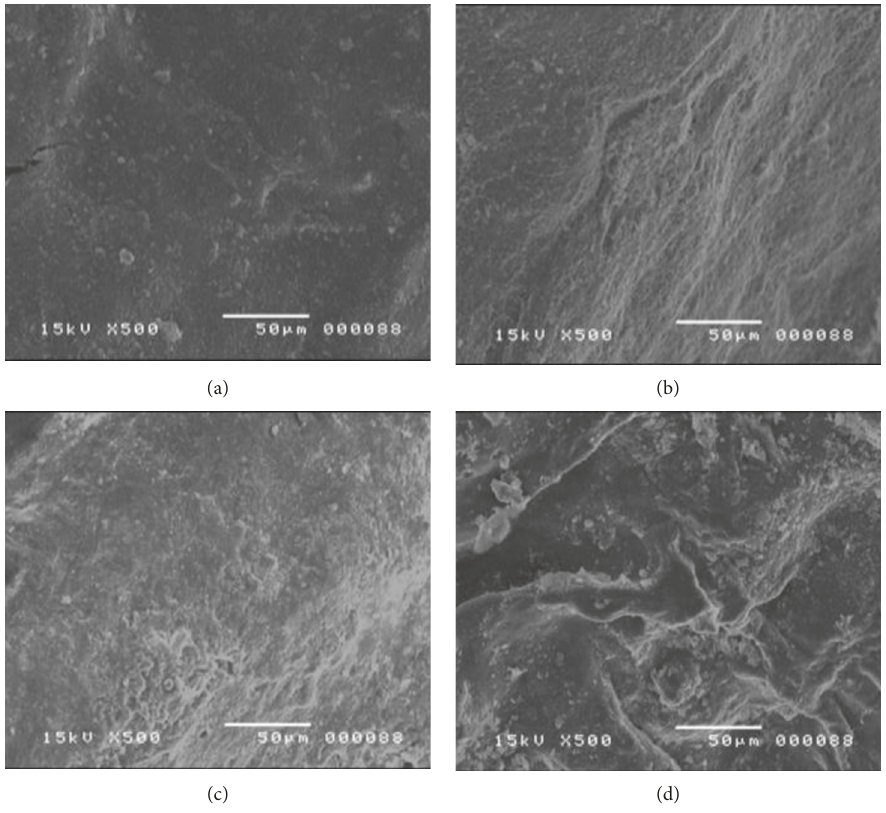
Figure 1: Scanning electron microscopic of coating layer: (a) C